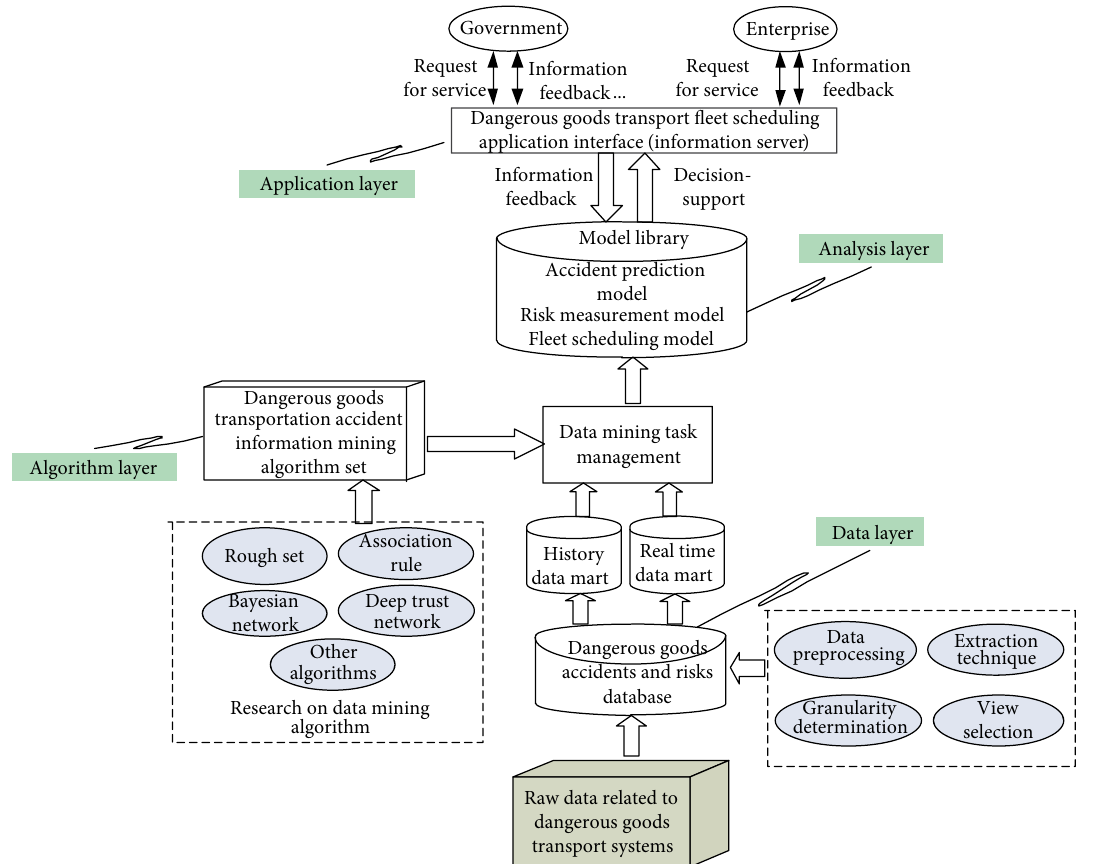
Figure 7: Framework of hazardous materials transport fleet dispatching